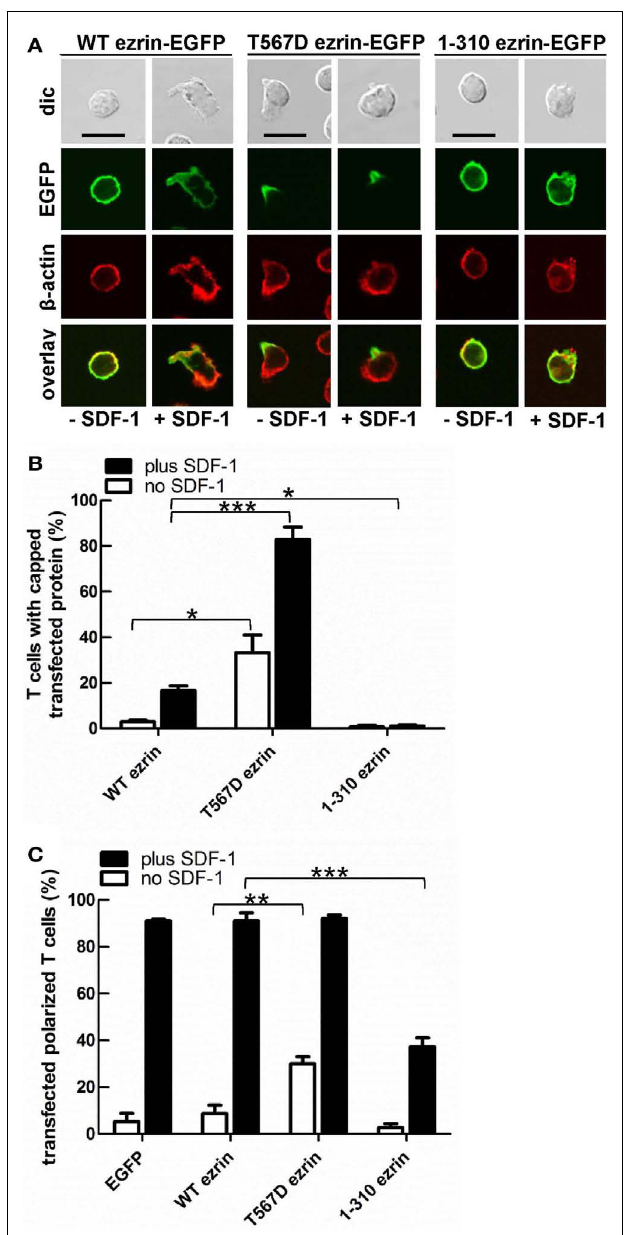
FIGURE 2 |Analysis of expression of wild type and mutant ezrin constructs in humanT cells in relation to endogenous ezrin. T cells were transiently transfected with the indicated constructs and EGFP-expressingT cells were sorted by FACS.The sorted cells were precipitated withTCA and subjected to immunoblotting, using an antibody reacting with the N-terminal domain of ezrin diluted 1:2000.The open arrow indicates endogenous ezrin (approximately 80kDa); the closed arrow indicates the EGFP-tagged full-length proteins (approximately 110kDa) and the arrowhead indicates the EGFP-tagged N-terminal ezrin fragment (approximately 60kDa). Numbers at the left indicate molecular masses (kDa) of standard proteins. Quantitative evaluation of this blot indicates that WT ezrin-EGFP is overexpressed by 210% andT567D ezrin-EGFP by 335% as compared to endogenous ezrin. 1–310 ezrin-EGFP shows a substantially lower expression (approximately 10% of the endogenous ezrin).